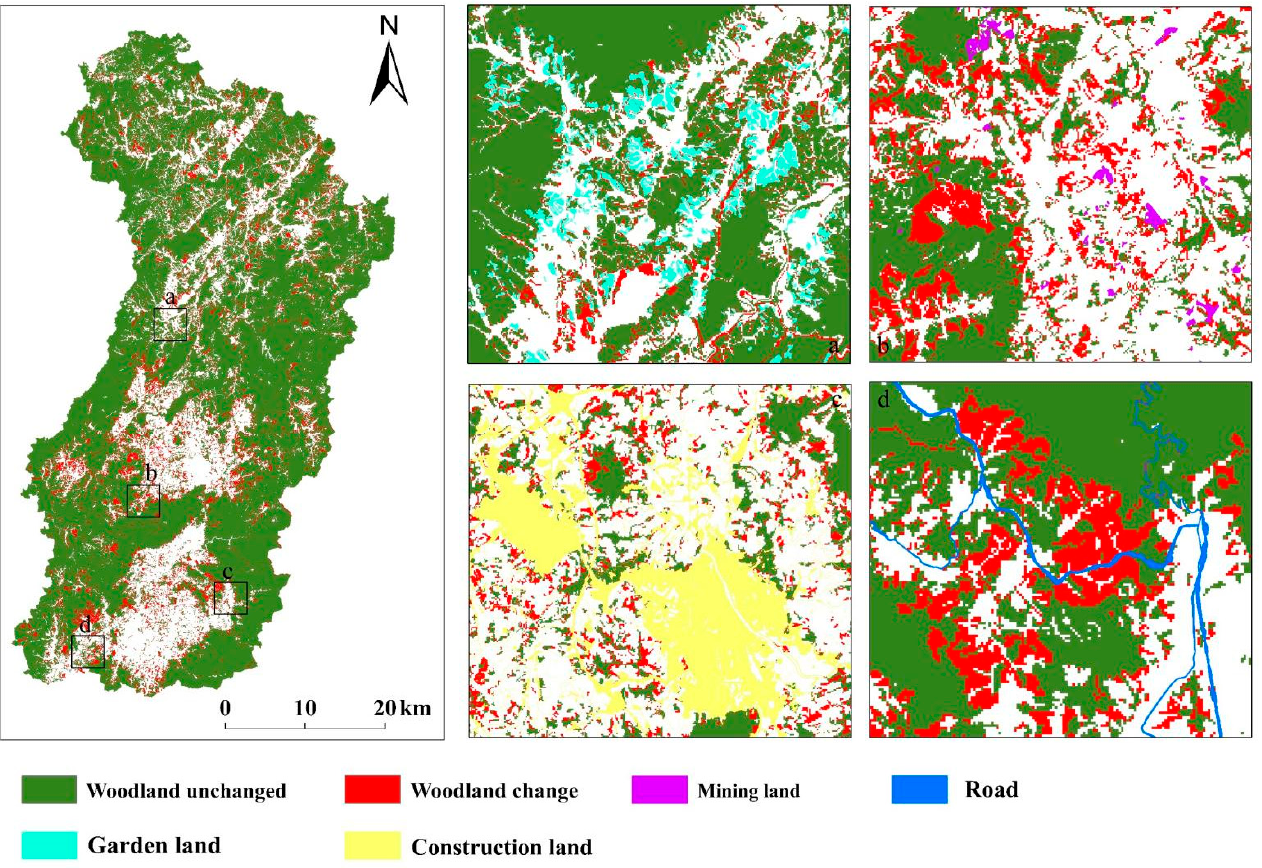
Figure 5. Location map of woodland changes in Anyuan County. （ a indicates woodland change around garden land, b indicates woodland change around mining land, c indicates woodland change around construction land and d indicates woodland change around roads. ）